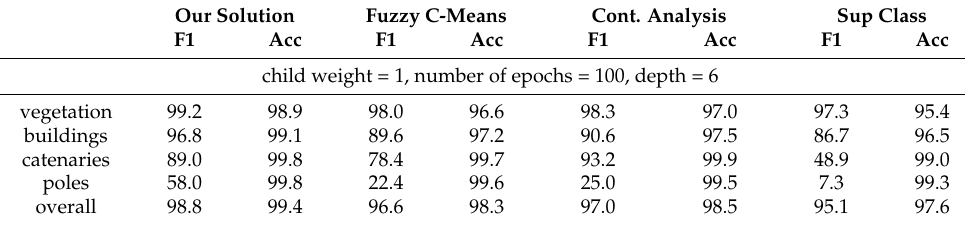
Table 5. Accuracy and F1 for Fuzzy C-Means, Cont. Analysis, Sup Class, and our solution. Our Solution Fuzzy